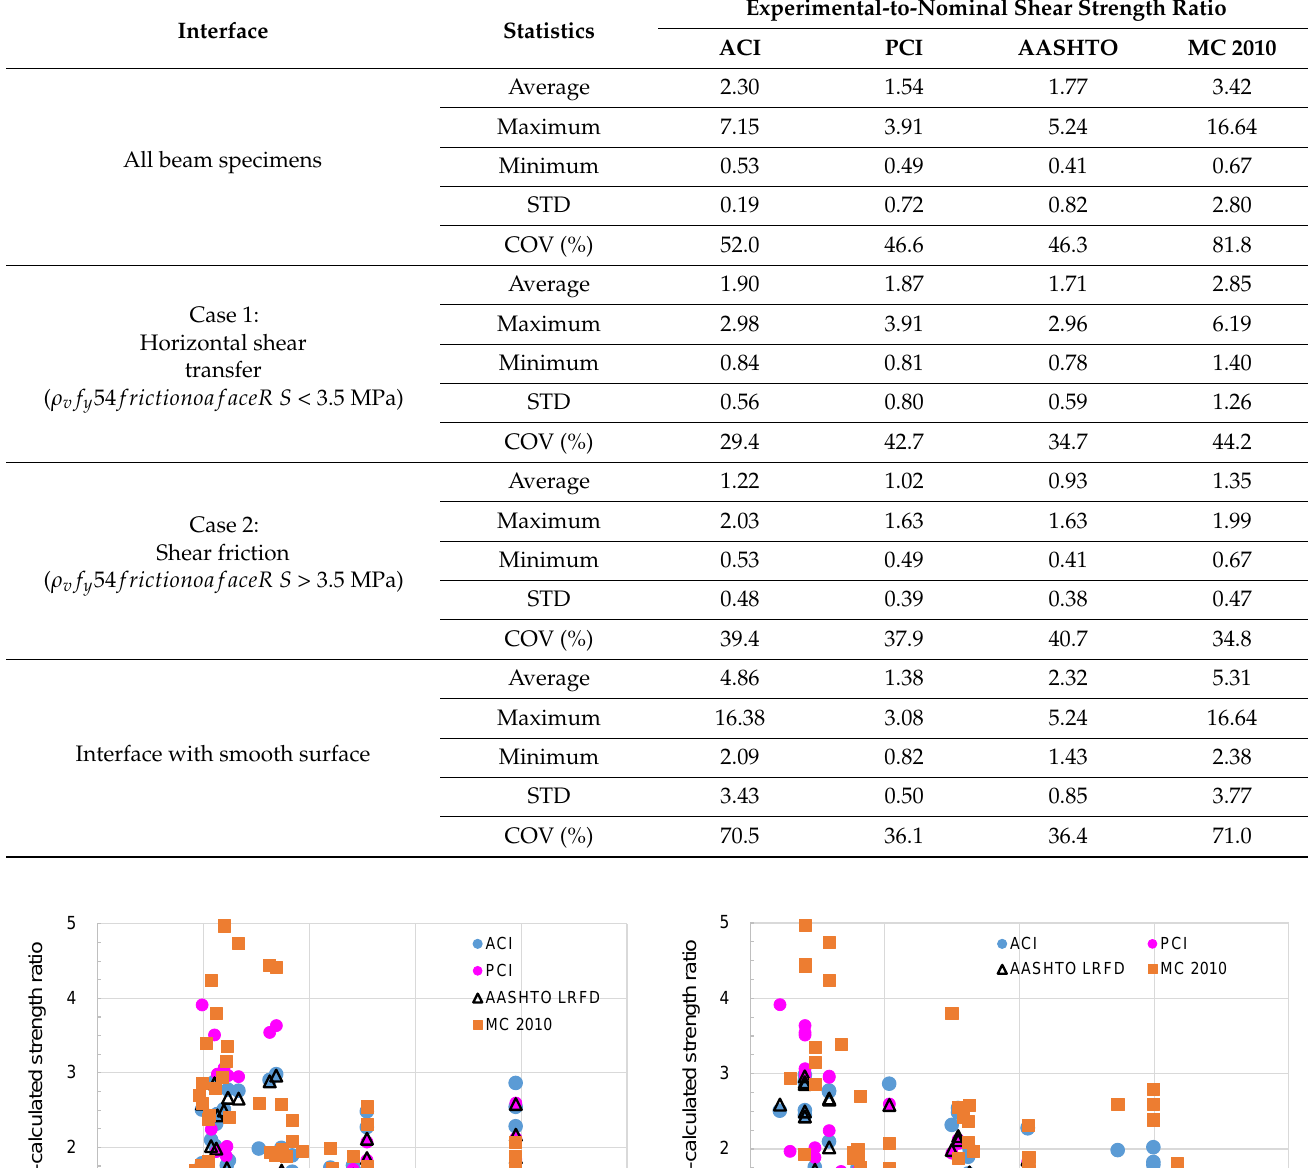
Table 6. Statistical analysis between design provisions and database from beam specimens.